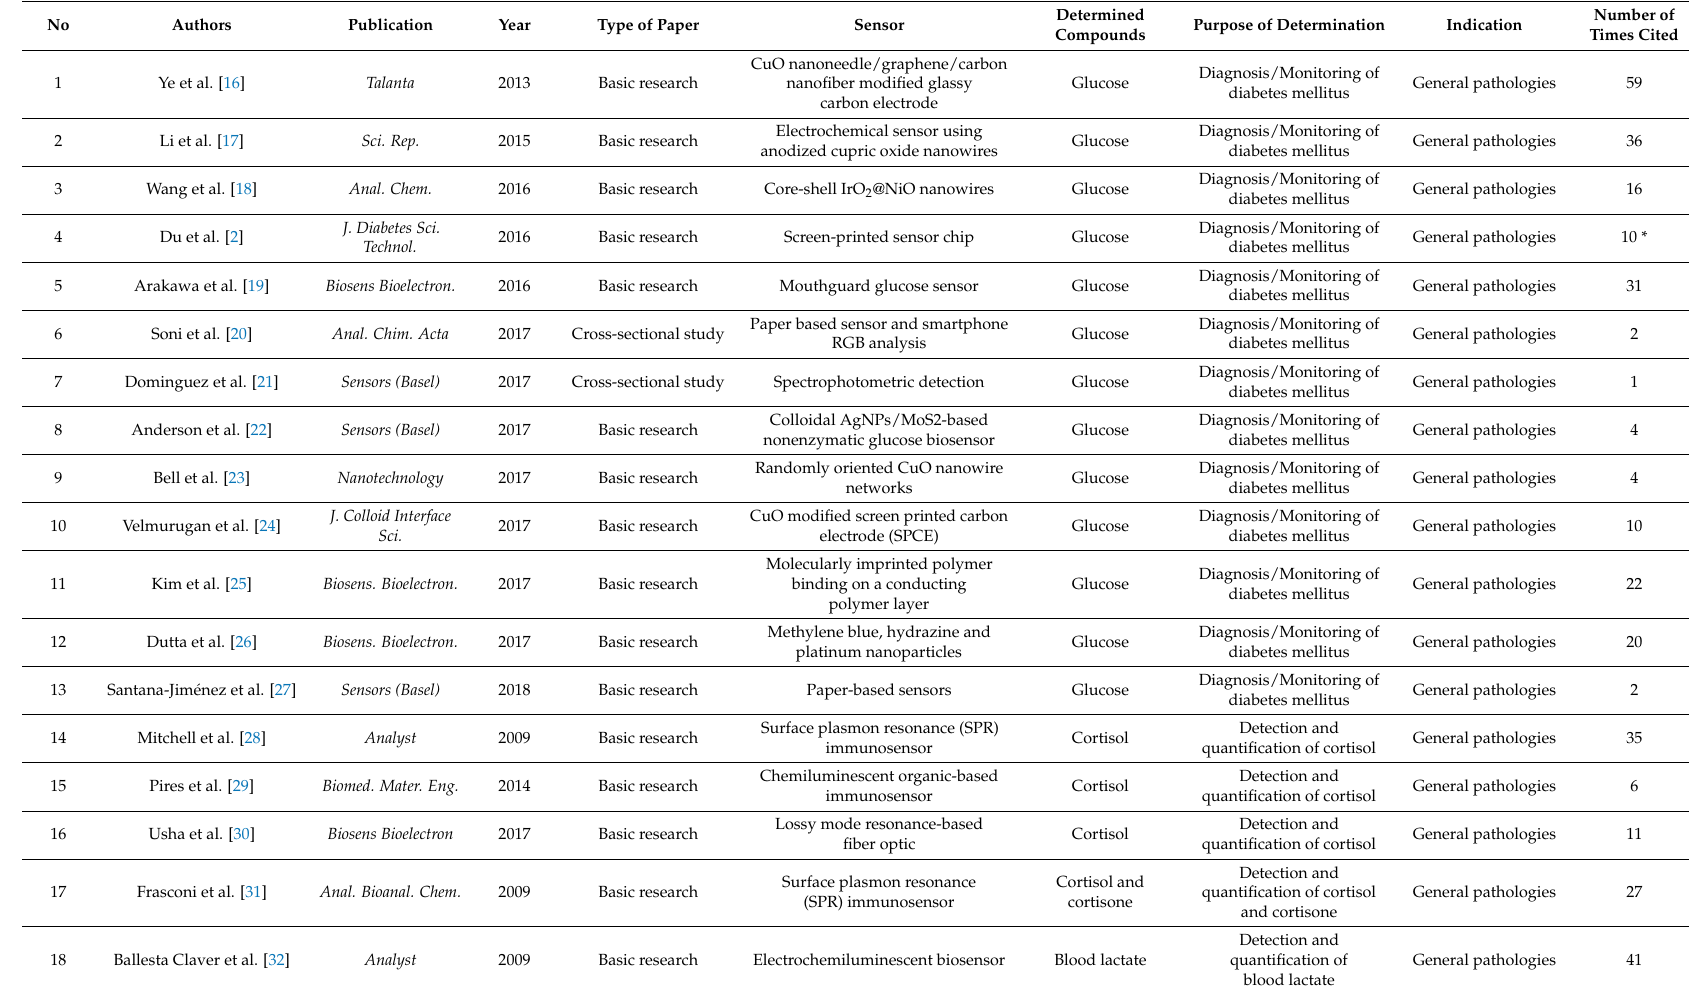
Table 1. The final eligible papers for the present